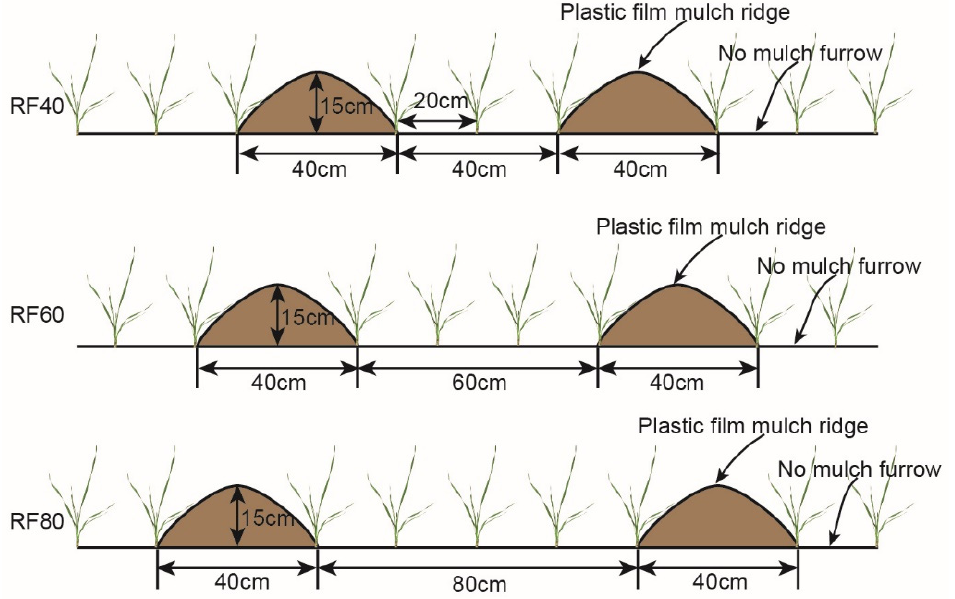
Figure 2. Schematic diagrams of the plastic-mulched ridge–furrow rainwater harvesting (RF) system under different ridge widths.